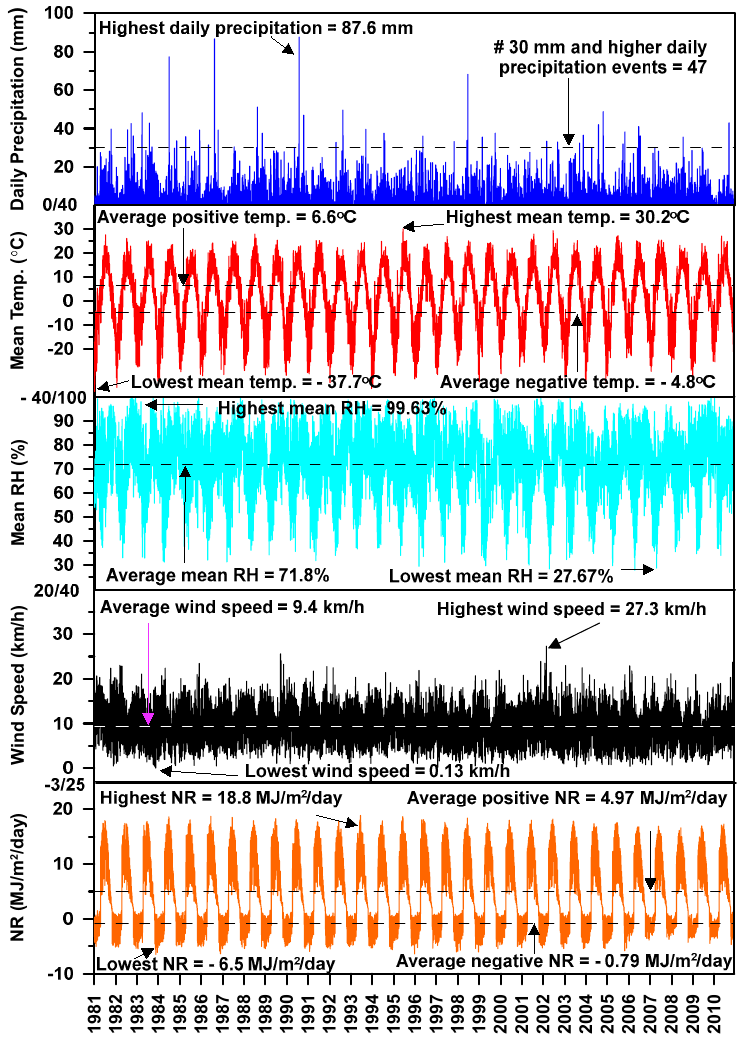
Figure 1. Thirty-year historical climate data for Timmins, Ontario.